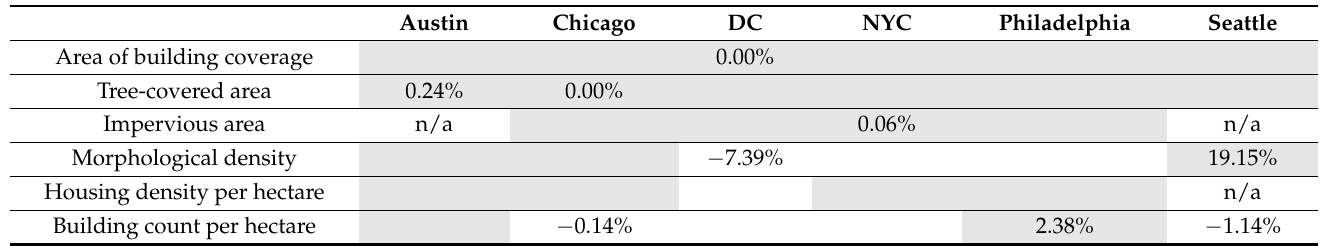
Table 4. A summary of the impacts of urban form and density variables on energy-use intensity (gray = positive correlation; white = negative correlation; numbers provided only for the statistically significant relationships). Austin Chicago DC NYC Philadelphia